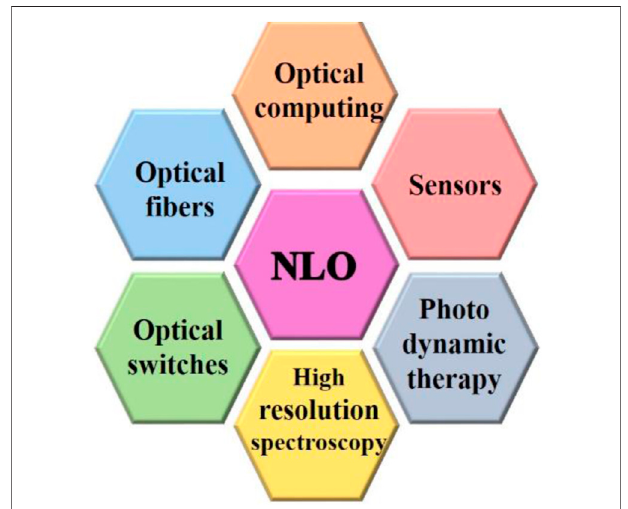
FIGURE 1 | Applications of nonlinear optical materials in various fi